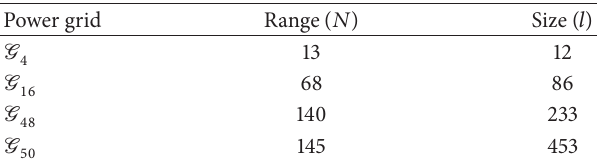
Table 2: Fittings of the CDF curves of test power grids using MATLAB’s curve fitting tool.